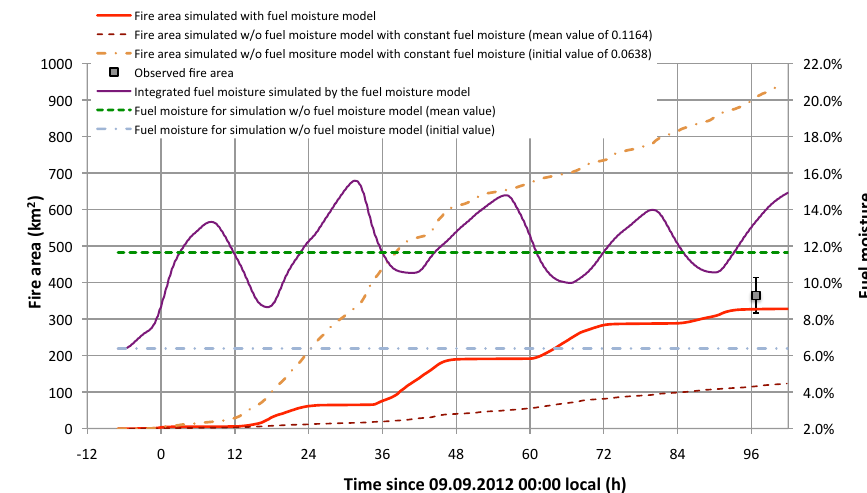
Figure 10. Time series of the WRF–SFIRE simulated fire area (solid lines), and the fuel moisture (dashed lines). The grey point shows the fire area observed on 13 September 2012, 00:44LT. The error bar shown is estimated from the spread of different reported perimeters. The sunrise in the simulation domain was about 06:30LT, and the sunset about 19:20LT. Note that the total fuel moisture contains contributions from all fuel classes as well, not only the fine fuels moisture, resulting in a larger time lag of the total fuel moisture after dawn and